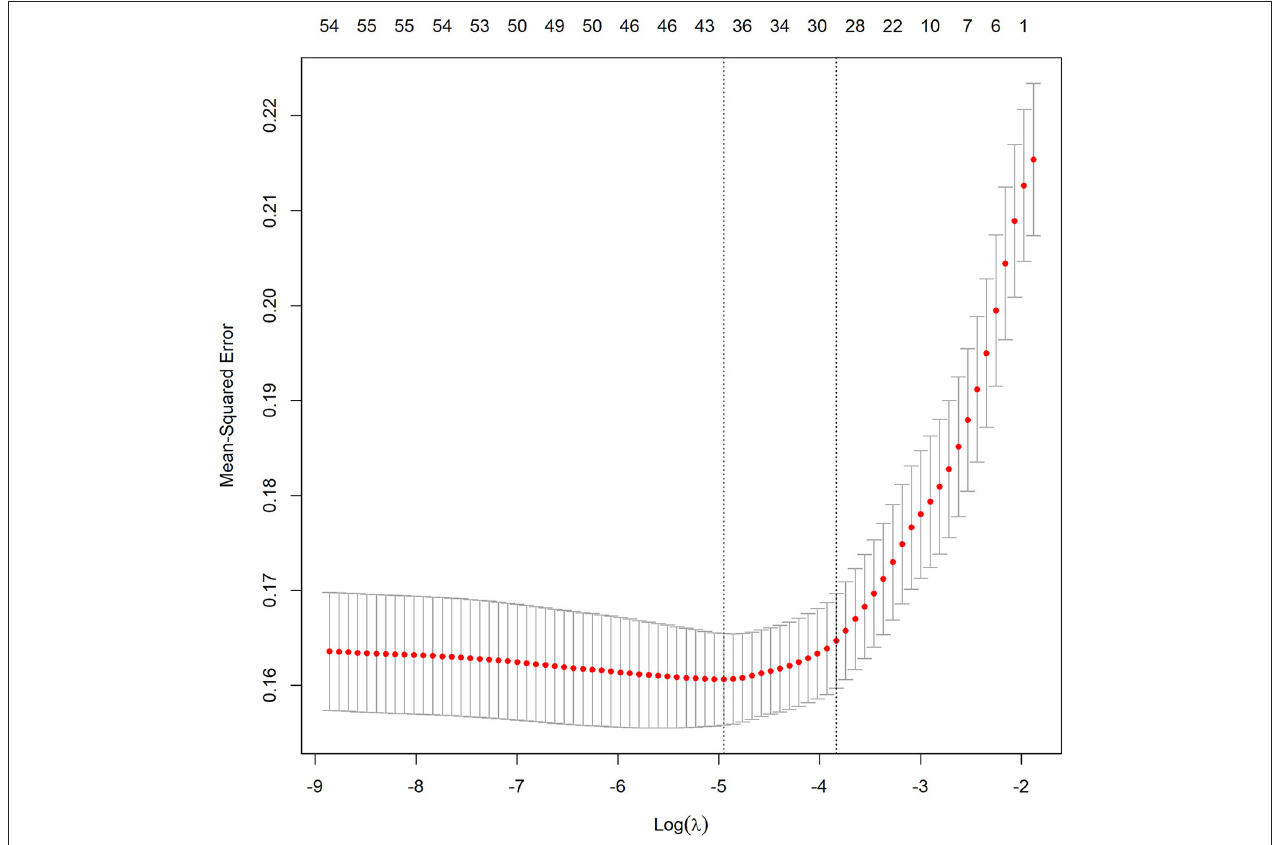
FIGURE 1 | Different mean-squared error across the range of lambda. The mean-squared error was estimated with cross-validation technique and the largest lambda value was chosen when the cross-validation error was within one standard error of the